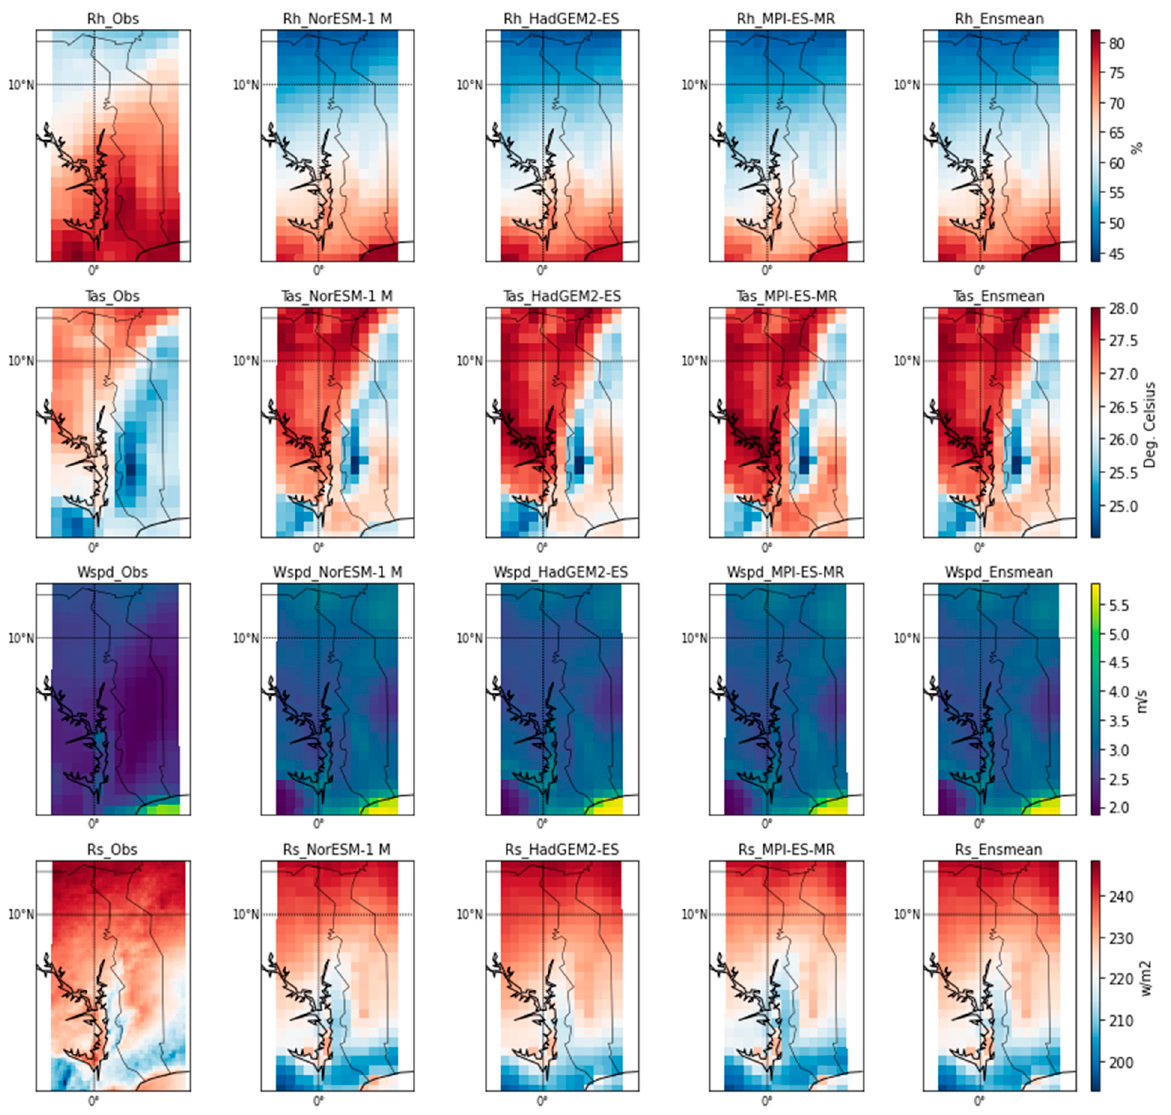
Figure 2. Rh, Tas, and Wspd at 10 m and Rs, in the present climate (1976–2005) of the RegCM4 driven by three ESMs (HadGEM2-ES, MPI-ES-MR, and NorESM-1 M) and its ensemble mean (Ensmean) between observation and simulations.